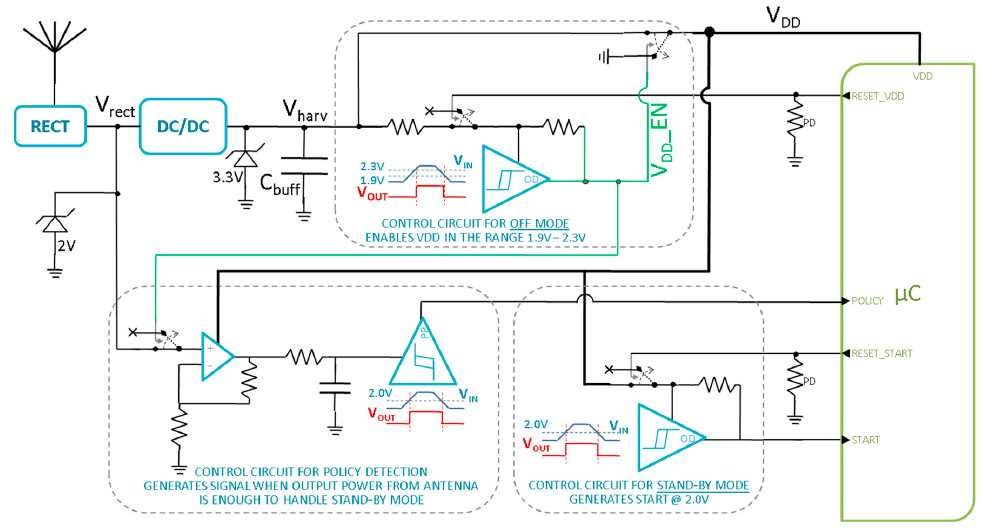
Figure 13. Schematic of the harvesting module and its interface with the active node.